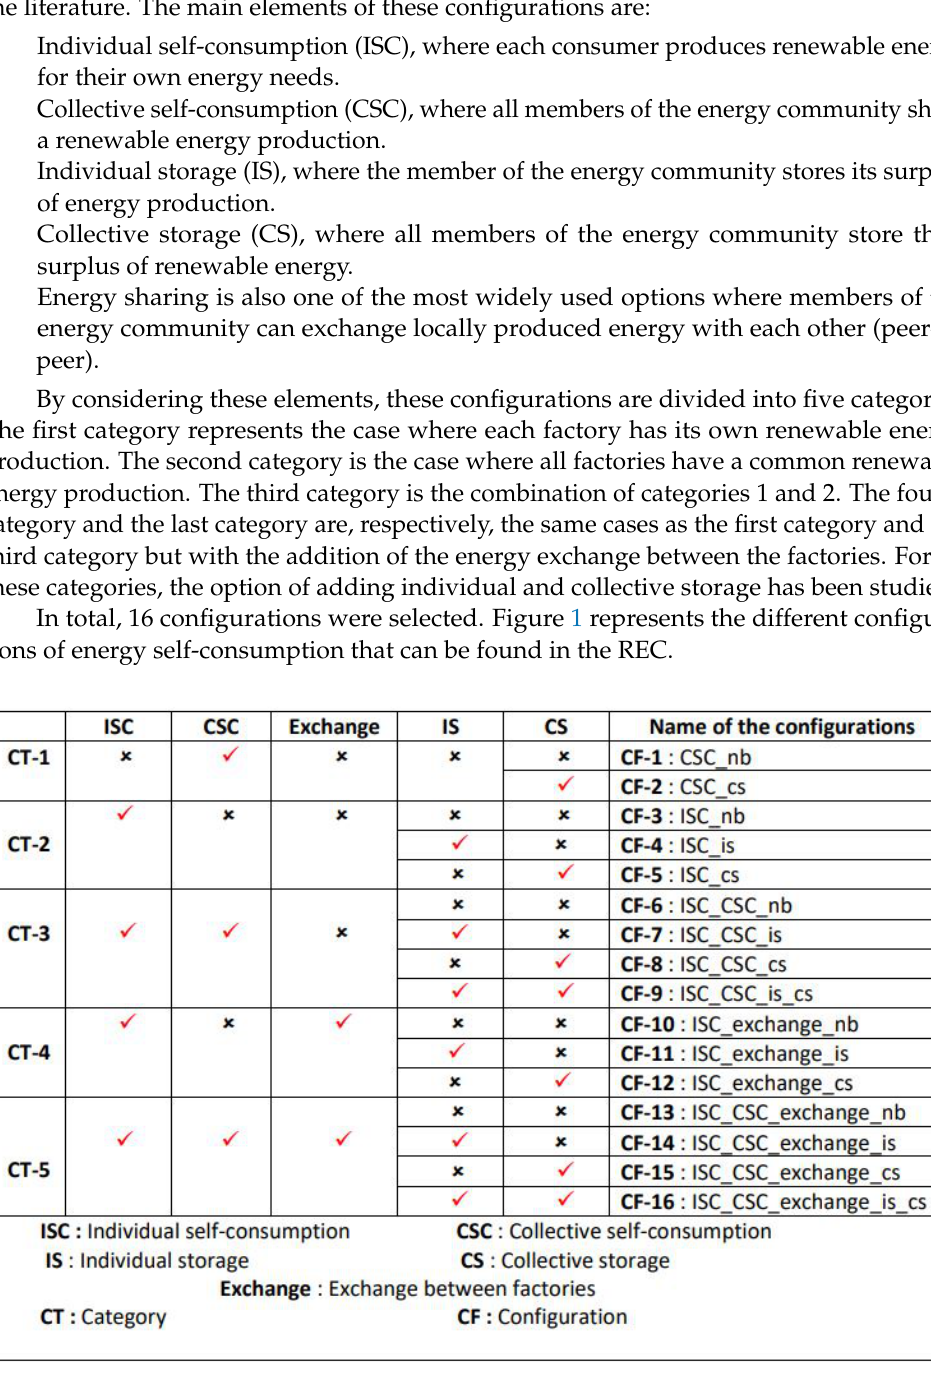
Figure 1. Different configurations of energy self-consumption in